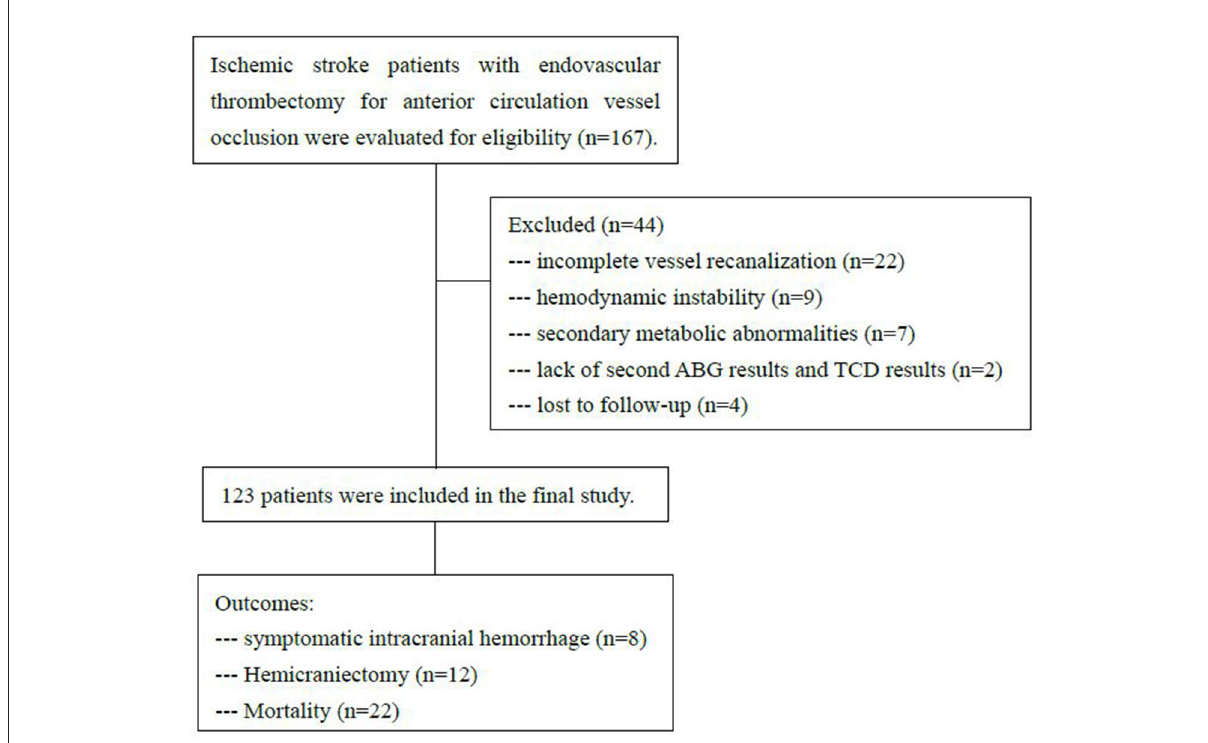
FIGURE1 Research flow chart. ABG, arterial blood gas (ABG); TCD, transcranial